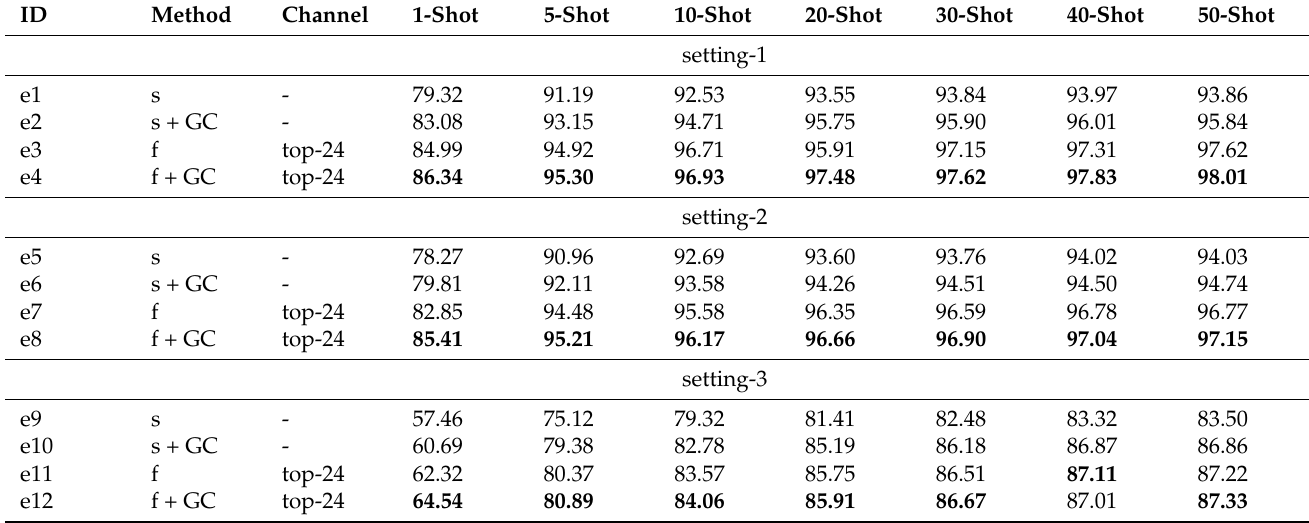
Table 1. The experimental results of the three data settings. ( f θ : Resnet12; filter-size: 8 × 8;